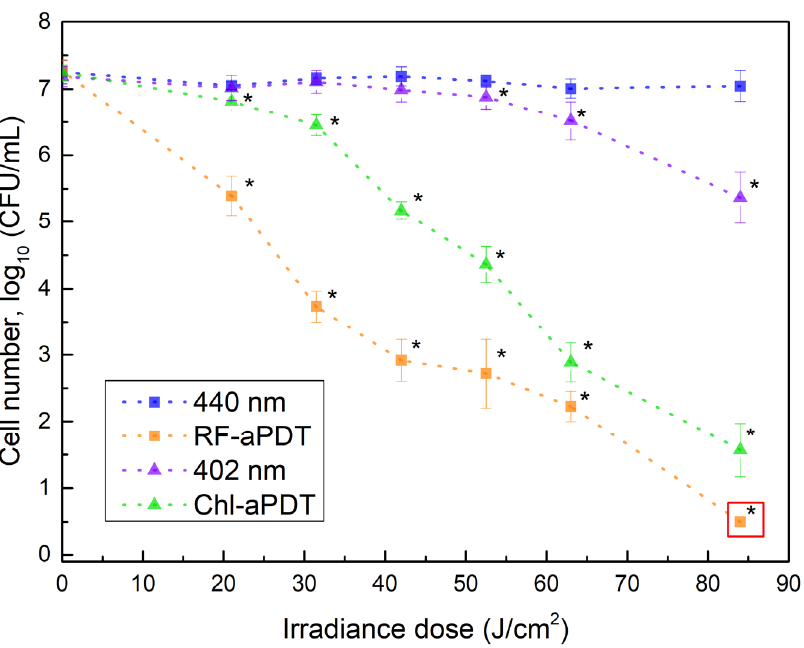
Figure 1. Inactivation of A. baumannii planktonic cells by aPDT as a function of irradiance doses (irradiance of 35 mW/cm 2 ). Samples in the legend: 440 nm and 402 nm—bacteria in 0.01 M PBS without PS; RF-aPDT—bacteria with 11 µM riboflavin (RF); Chl-aPDT—bacteria with 15 µM chlorophyllin (Chl). Every point is the average of 3–6 independent experiments (10 µL), error bars indicate standard deviation. * indicates statistical significance compared to control culture, p < 0.05. The red square means the point detection limit (200 µL 0.5 log 10 ). The detection limit of other points is 2 log 10 . Table 1. Irradiance doses at 402 nm and 440 nm used in experiments. Planktonic Cells Biofilms